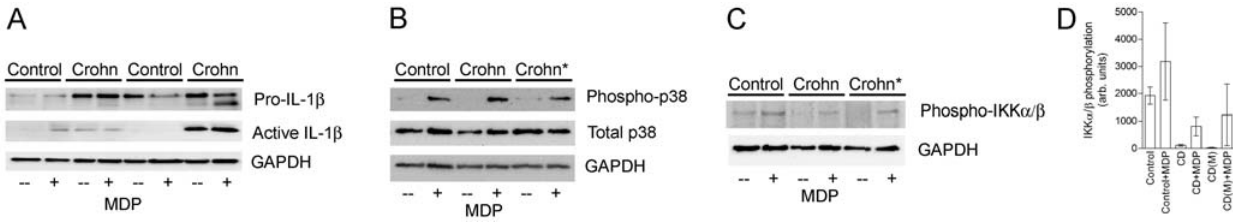
Figure 2. MDP-induced expression IL-1 b and activation of p38 and IKK a / b . Immunoblotting of IL-1 b (A), p38 (B), and IKK a / b (C). Quatitative IKK a / b phosphorylation, bars represent ranges (D). Monocytes were stimulated for 24 hours with MDP. IL-1 b expression was increased in CD patients, but no response was seen to MDP. Monocytes stimulated with MDP had increased p38 phosphorylation, regardless of disease status. Contrary to the p38 response, reduced IKK a / b phosphorylation was seen in CD regardless of CARD15 status. Control monocytes did respond to MDP stimulation by